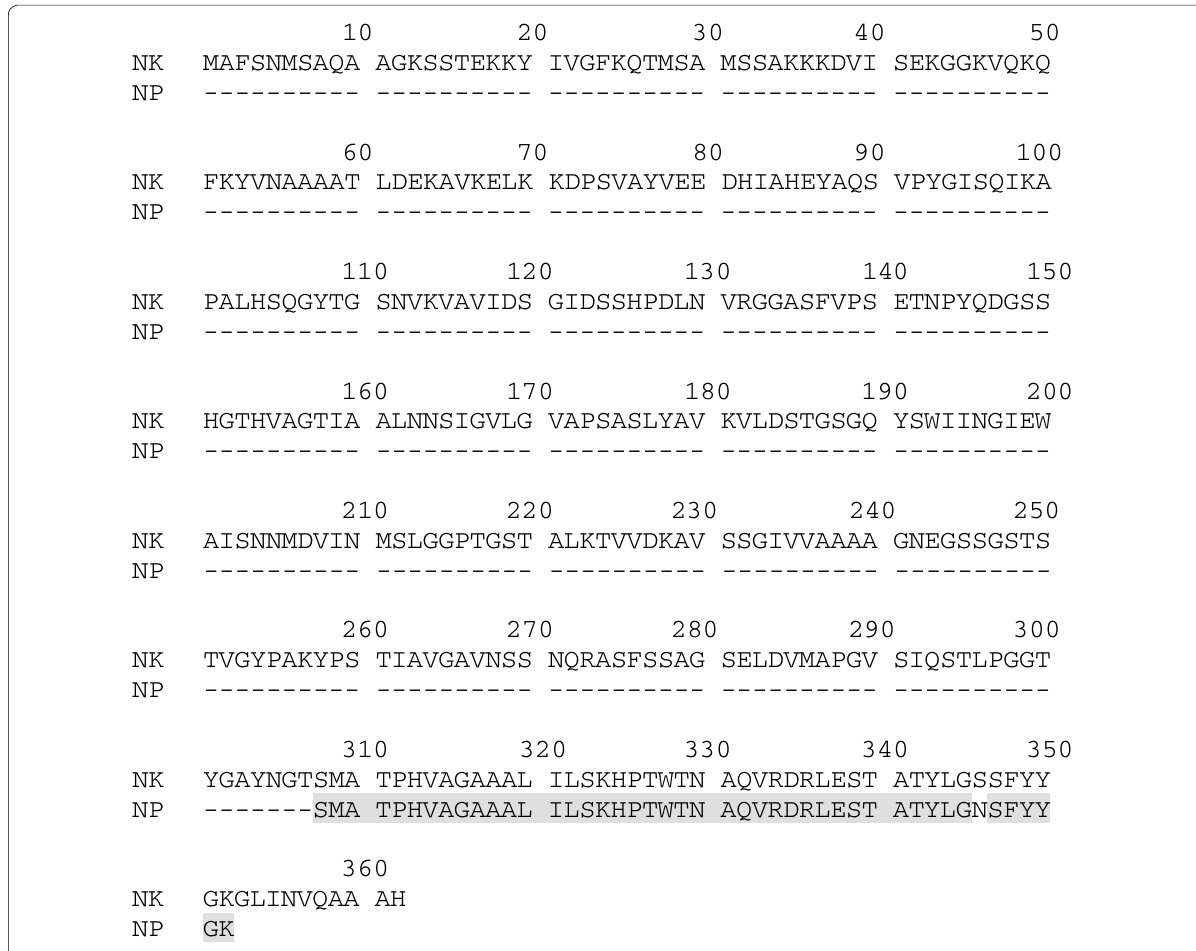
Fig. 2 Comparison of amino acid sequence of nattokinase (NK) and Natto peptide (NP). The amino acid sequence of NK is cited from